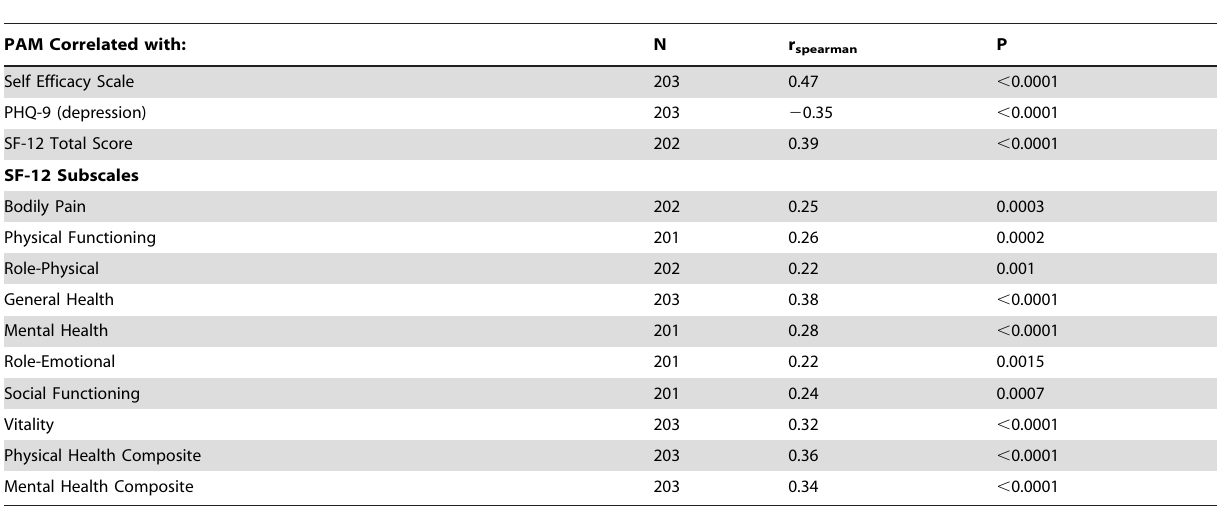
Table 3. Correlation of PAM with PHQ-9, SF-12 and Self Efficacy Scales.